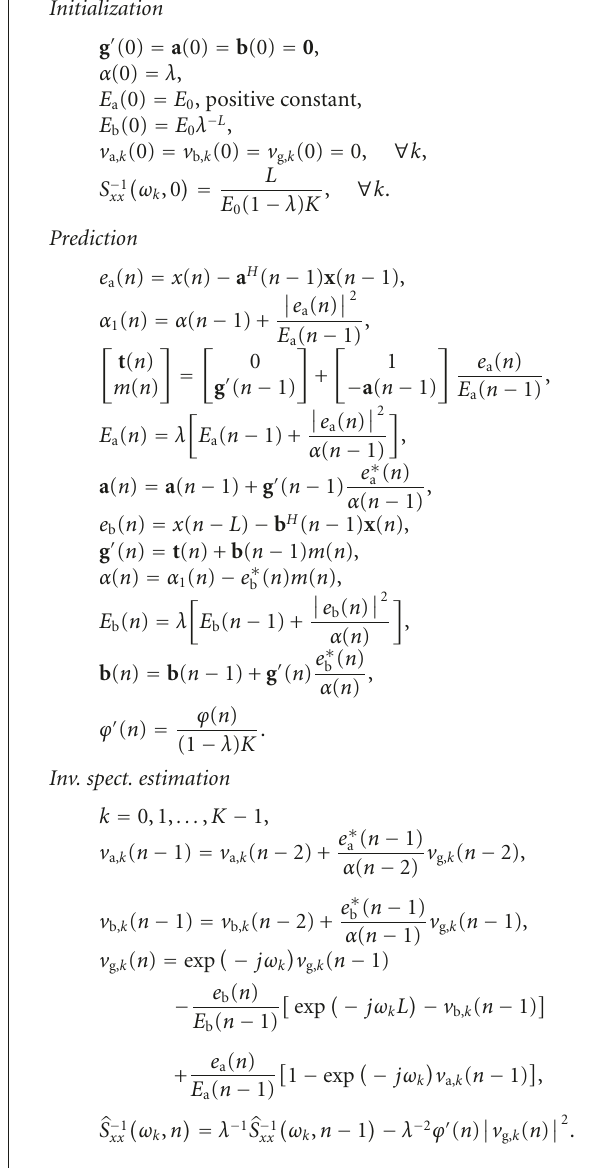
Algorithm 2: A fast recursive Capon inverse spectral